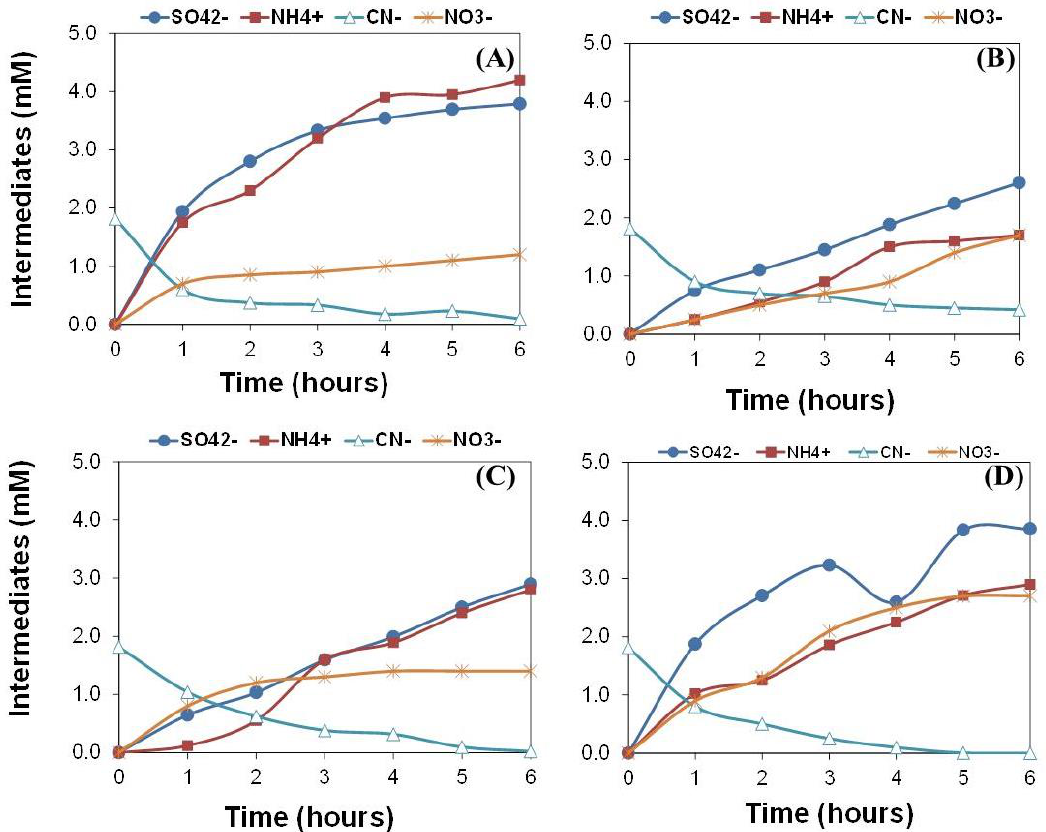
Figure 2. Intermediates detected in the wastewater upon illumination with various light sources: ( A ) UVC lamp; ( B ) UV-Vis lamp; ( C ) SimSolar lamp; ( D ) SimSolar lamp in the presence of TiO 2 as photocatalyst.